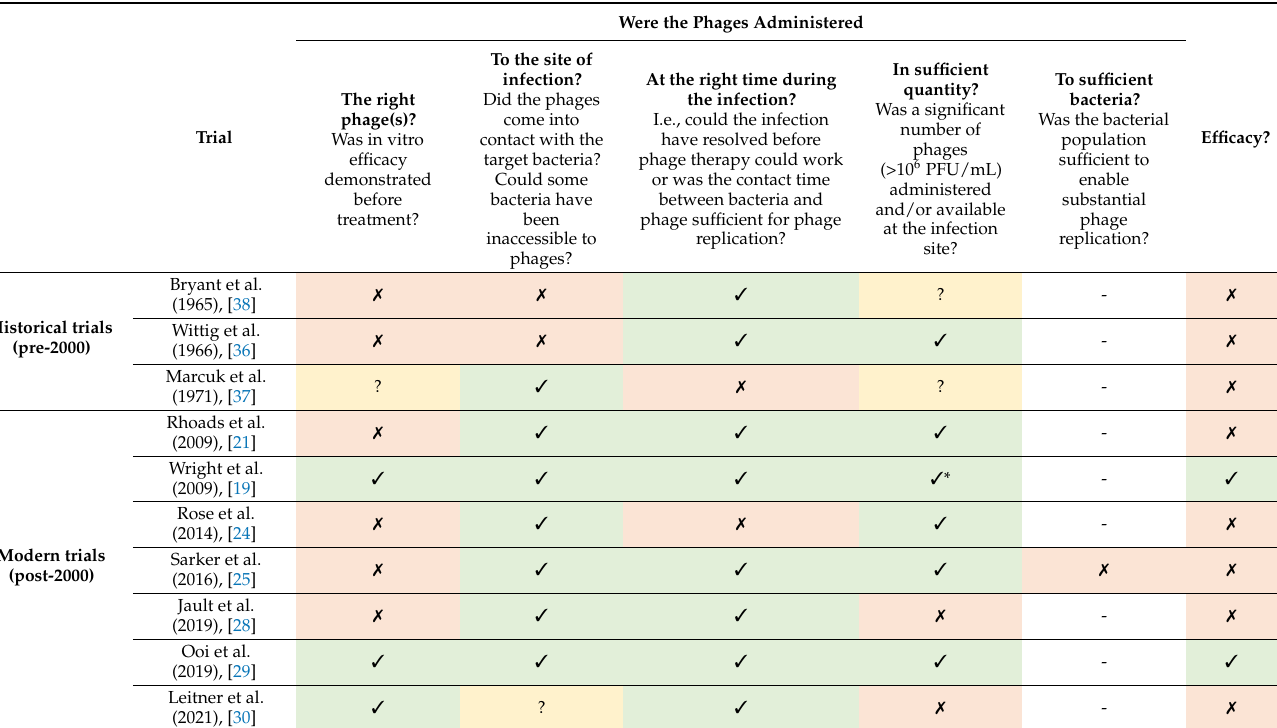
Table 1. A summary of clinical and safety trials of phage therapy. Yes: (cid:51) ; no: (cid:55) ; unclear: ?. * The phage titre used was 6 × 10 5 PFU/mL. Only one paper commented that there were likely insufficient bacteria to enable phage